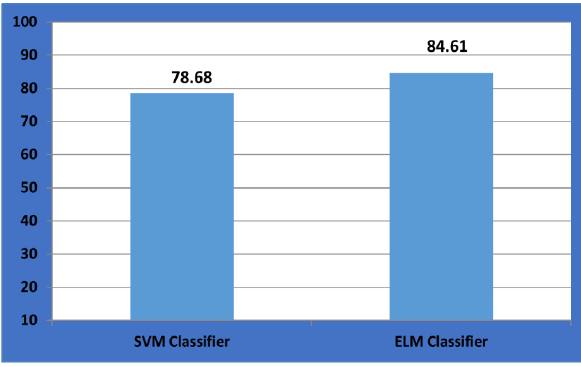
Figure 7. Accuracy comparison .